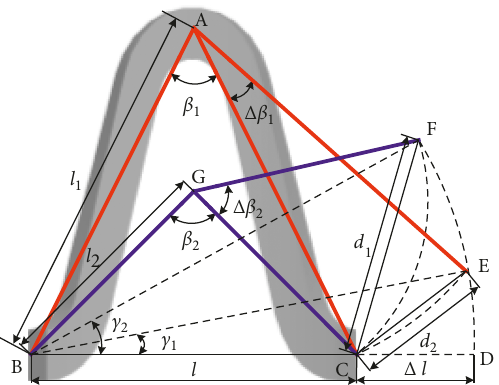
Figure 4: Geometrical relationships of the simplified supporting